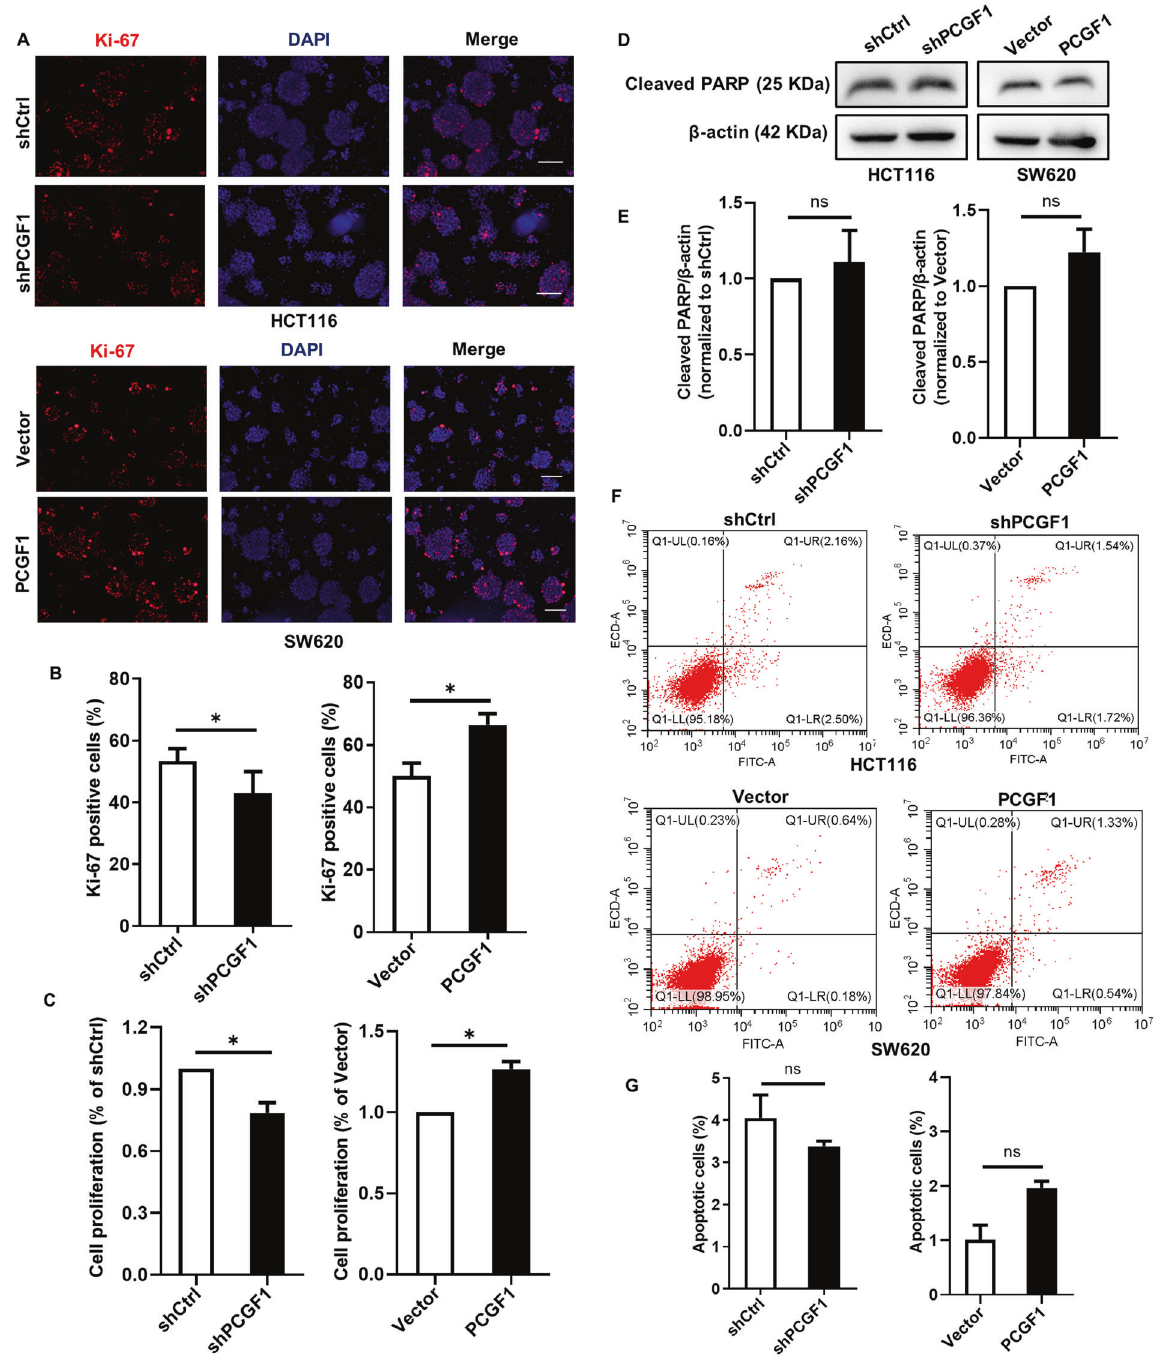
Fig. 4 PCGF1 promotes colorectal cancer stem cell proliferation. A , B Proliferation was detected by Ki-67 staining. Bar graphs show the statistical data for the Ki-67-positive cells. Scale bar, 100 µm. C CRC stem cell proliferation was examined by a CCK-8 assay. D , E The expression of cleaved PARP was analysed by western blot, and the relative intensity values (cleaved PARP/ β -actin) were measured with ImageJ software. F , G Cell apoptosis was examined by fl ow cytometry based on AV-PI staining. The histograms show the percentage of apoptotic cells. shCtrl, shControl. *p < 0.05 , t -test. Data are shown as the mean ± SEM of at least three replicates. β -actin was used as a loading